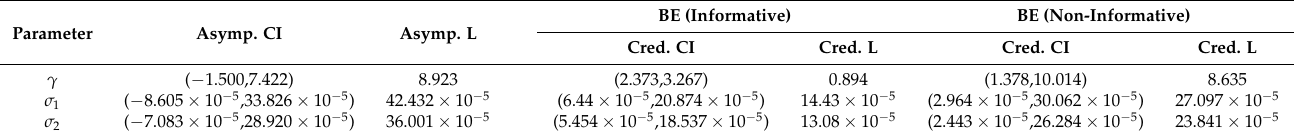
Table 7. 95% CIs with their lengths of the parameters γ , σ 1 and σ 2 for application 2. BE (Informative) BE (Non-Informative) Parameter Asymp. CI Asymp. L Cred. CI Cred. L Cred. CI Cred.